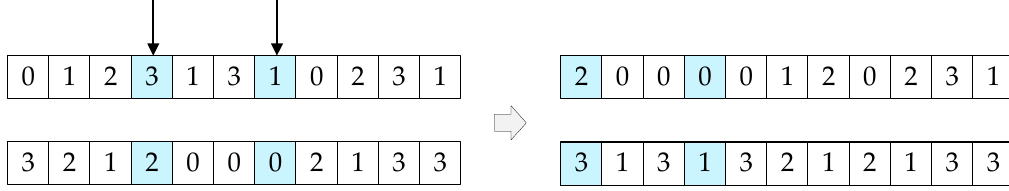
Figure 14. Gene crossover process.